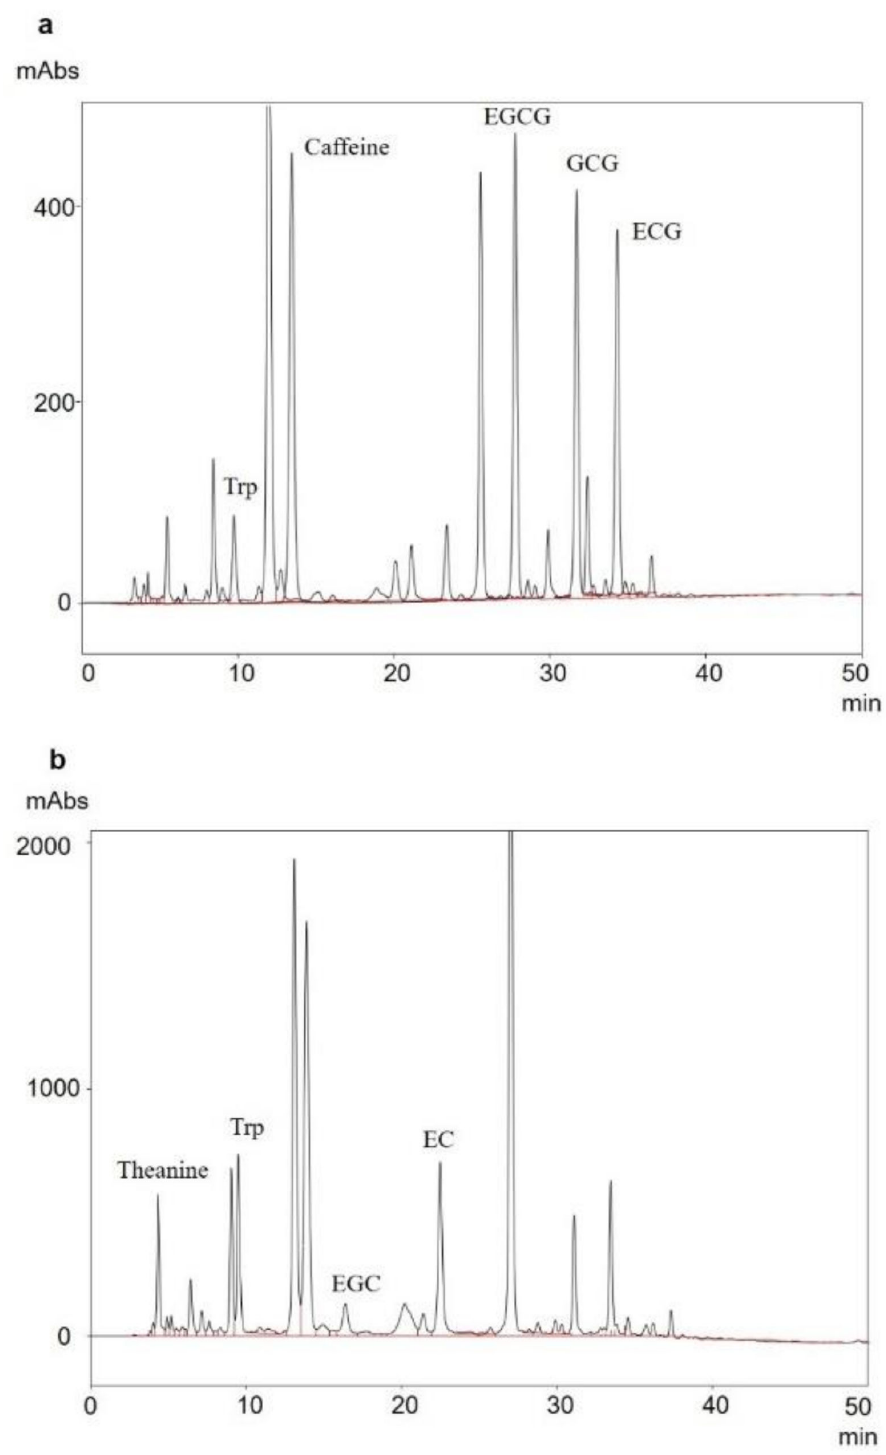
Figure 2. HPLC chromatogram of a typical green tea sample separating the internal standard (0.002% L-tryptophan (Trp)) and the target constituents (theanine, caffeine, EGC, EC, EGCG, GCG and ECG) detected at UV ( a ) 280 nm and ( b ) 210